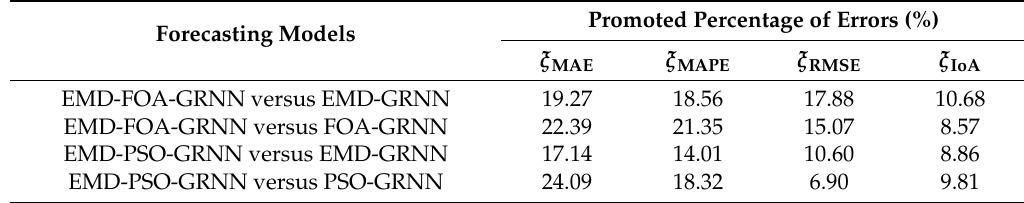
Table 5. Promoted percentage of errors in Case